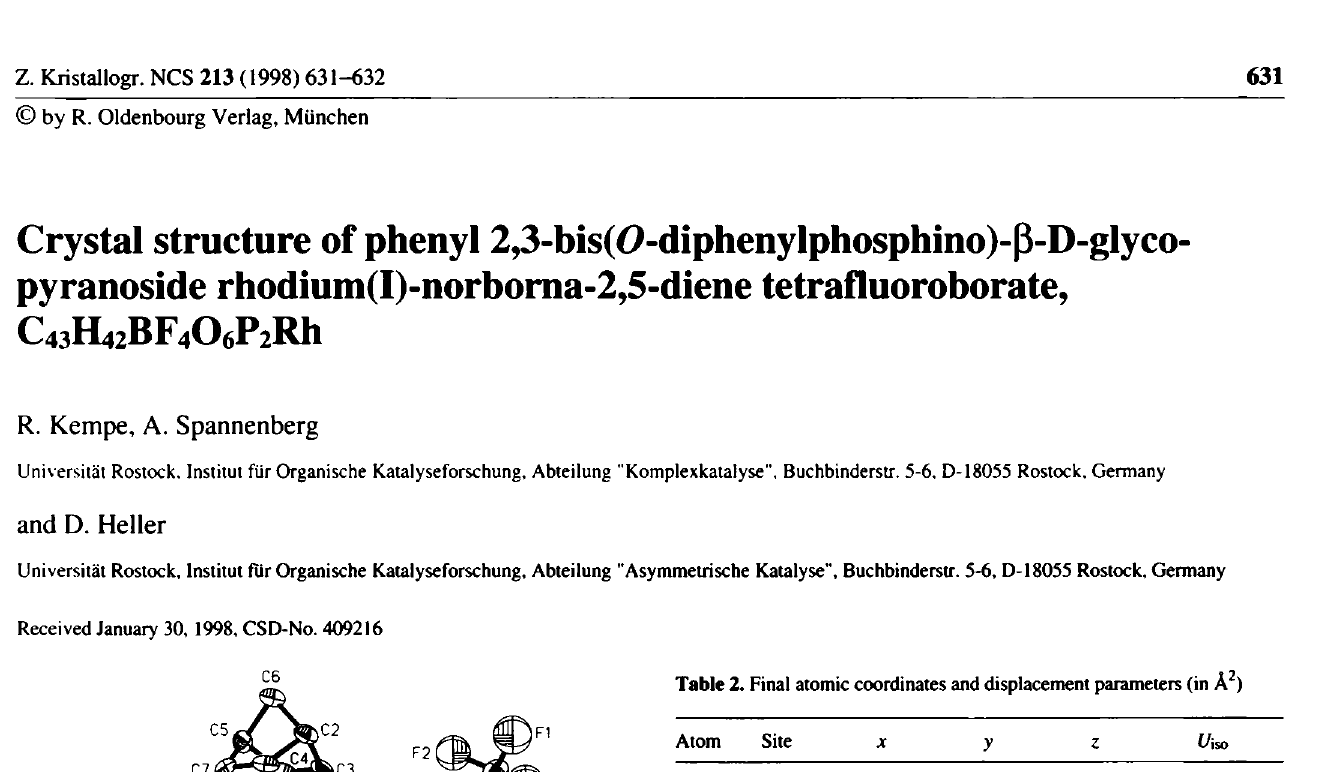
Table 2. Final atomic coordinates and displacement parameters (in A^)